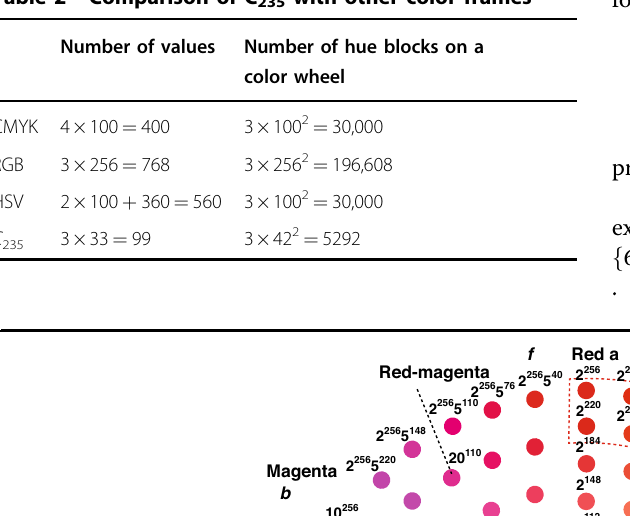
Table 2 Comparison of C 235 with other color frames